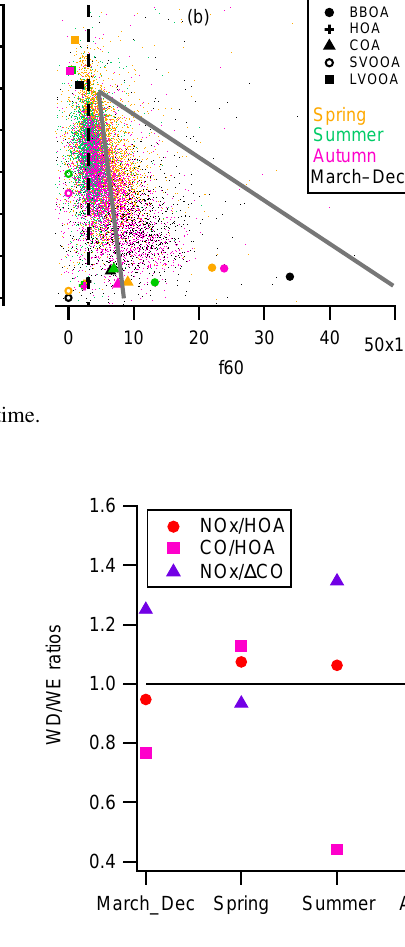
Figure 5. WD / WE ratios to analyse petrol and diesel contribu-